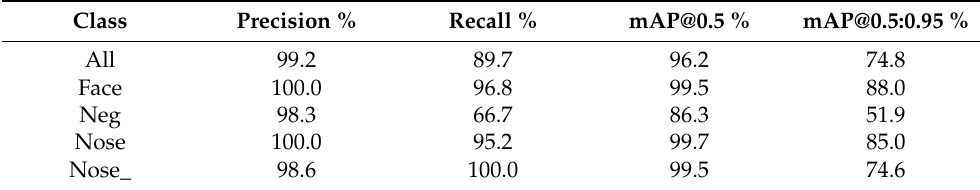
Table 2. Metrics of Transfer Learning for the Evaluation of Model Performance.